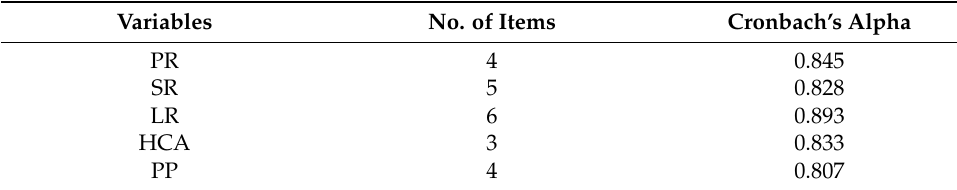
Table 4. Reliability analysis of